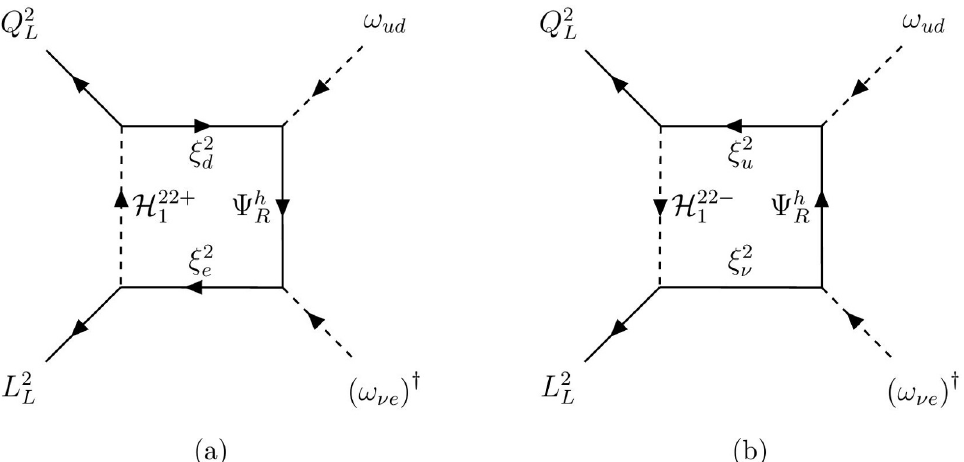
¯ Q 2 γ µ L 2 U µ interaction, induced by the exchange of L L